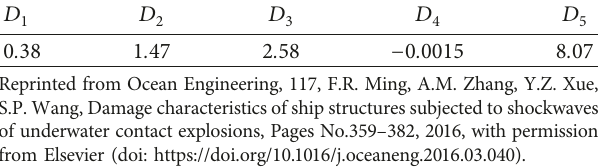
Table 5: The relevant parameters for the fracture model [46]. D D 1